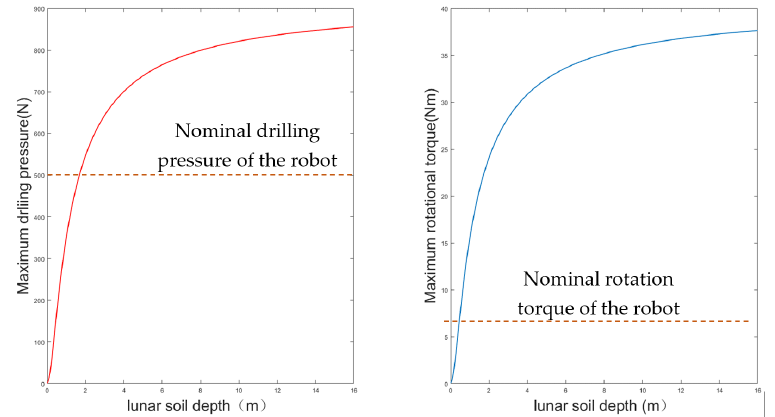
Figure 9. Maximum drilling pressure and rotational torque in relation to depth.